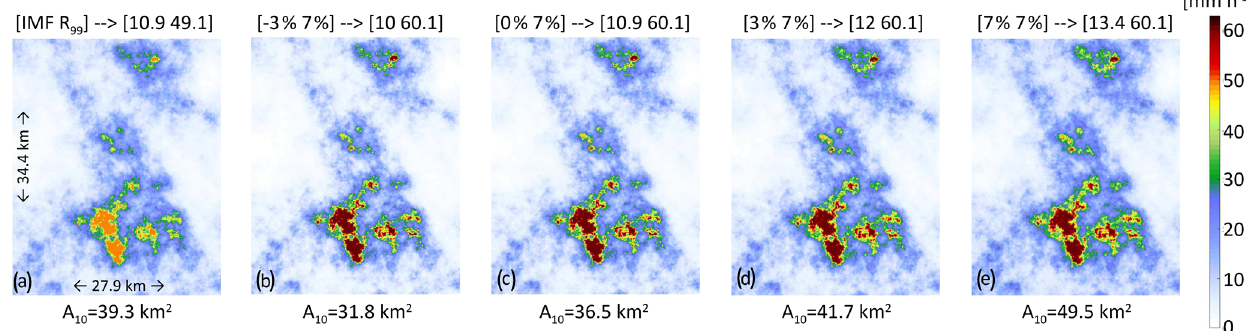
Figure 3. (a) An example of a stratiform simulated rainfall field for a given time step. (b–e) Plots of the rainfall field with four different “areal rainfall scenarios” (Table 1) and for a specific “temperature scenario” of (cid:49)T = 3 ◦ C. IMF refers to changes in the mean areal rainfall (% ◦ C − 1 ) and R 99 refers to changes in the peak rainfall intensity (% ◦ C − 1 ) in comparison to (a) ; the absolute values of mean areal rainfall and peak rainfall intensity are given in parentheses (mmh − 1 ). A 10 refers to the total area (km 2 ) above a rain intensity threshold of 10mmh − 1 .